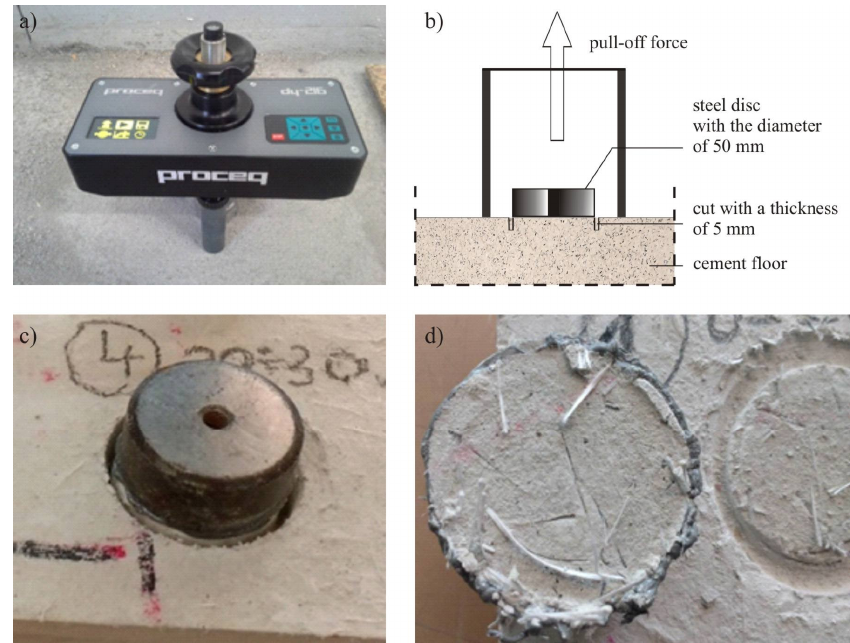
Figure 6. Control of the subsurface tensile strength of the floor using the pull-off method: ( a ) pull-off apparatus; ( b ) scheme of the method; ( c ) view of the glued steel disc; ( d ) view of the floor surface after the pull-off tests.